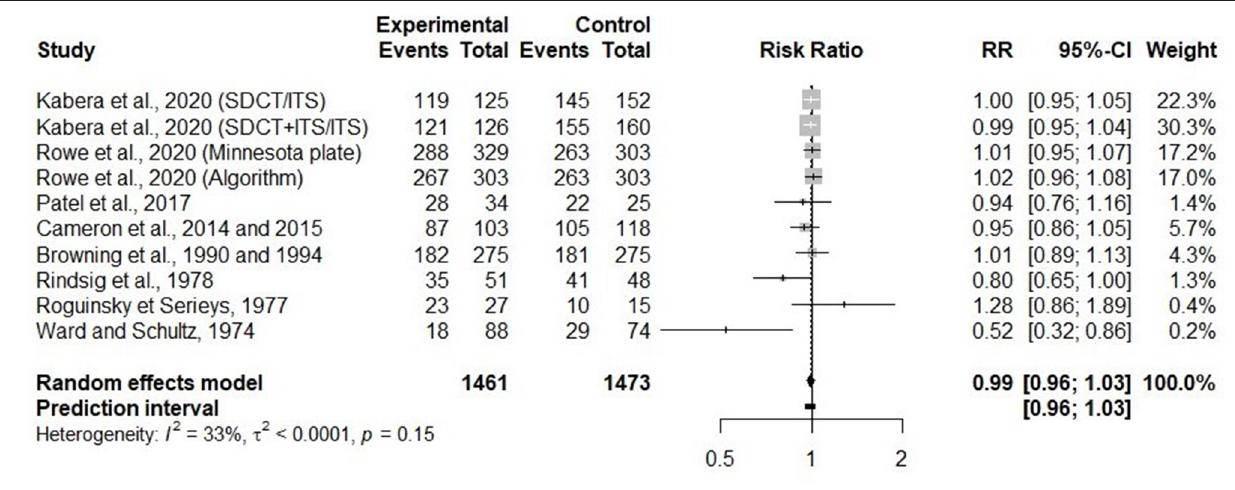
FIGURE 5 | Forest plots showing the effect of selective dry cow treatment compared with blanket dry cow therapy on risk of IMI elimination during the dry period.